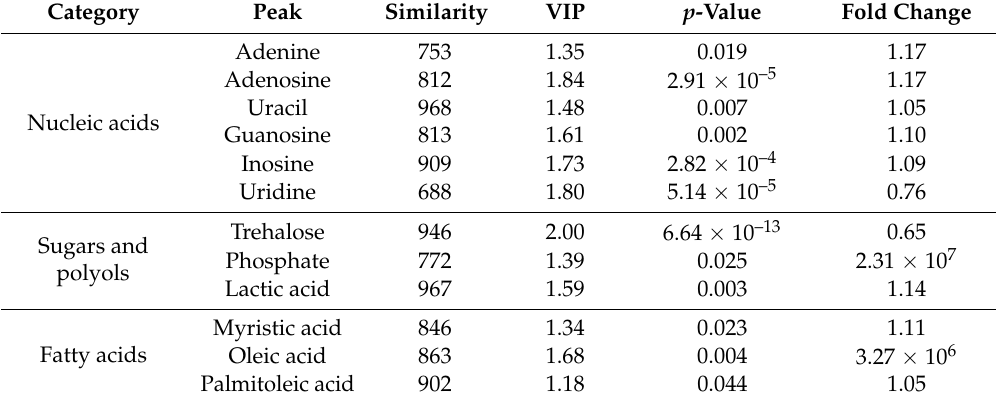
Major metabolite changes in white-backed planthopper (WBPH) with Southern rice black-streaked dwarf virus (SRBSDV infection). By gas chromatography-time of flight-mass spectrometry (GC-TOF-MS) analyses of six biological replicates of virus-carrying and virus-free WBPH at 25 ◦ C, the metabolites that had a variable influence on projections (VIP) > 1.0 and p -value < 0.05 were considered to be significantly altered metabolites. Nucleic acids, sugars and polyols, and fatty acids were selected to show in the